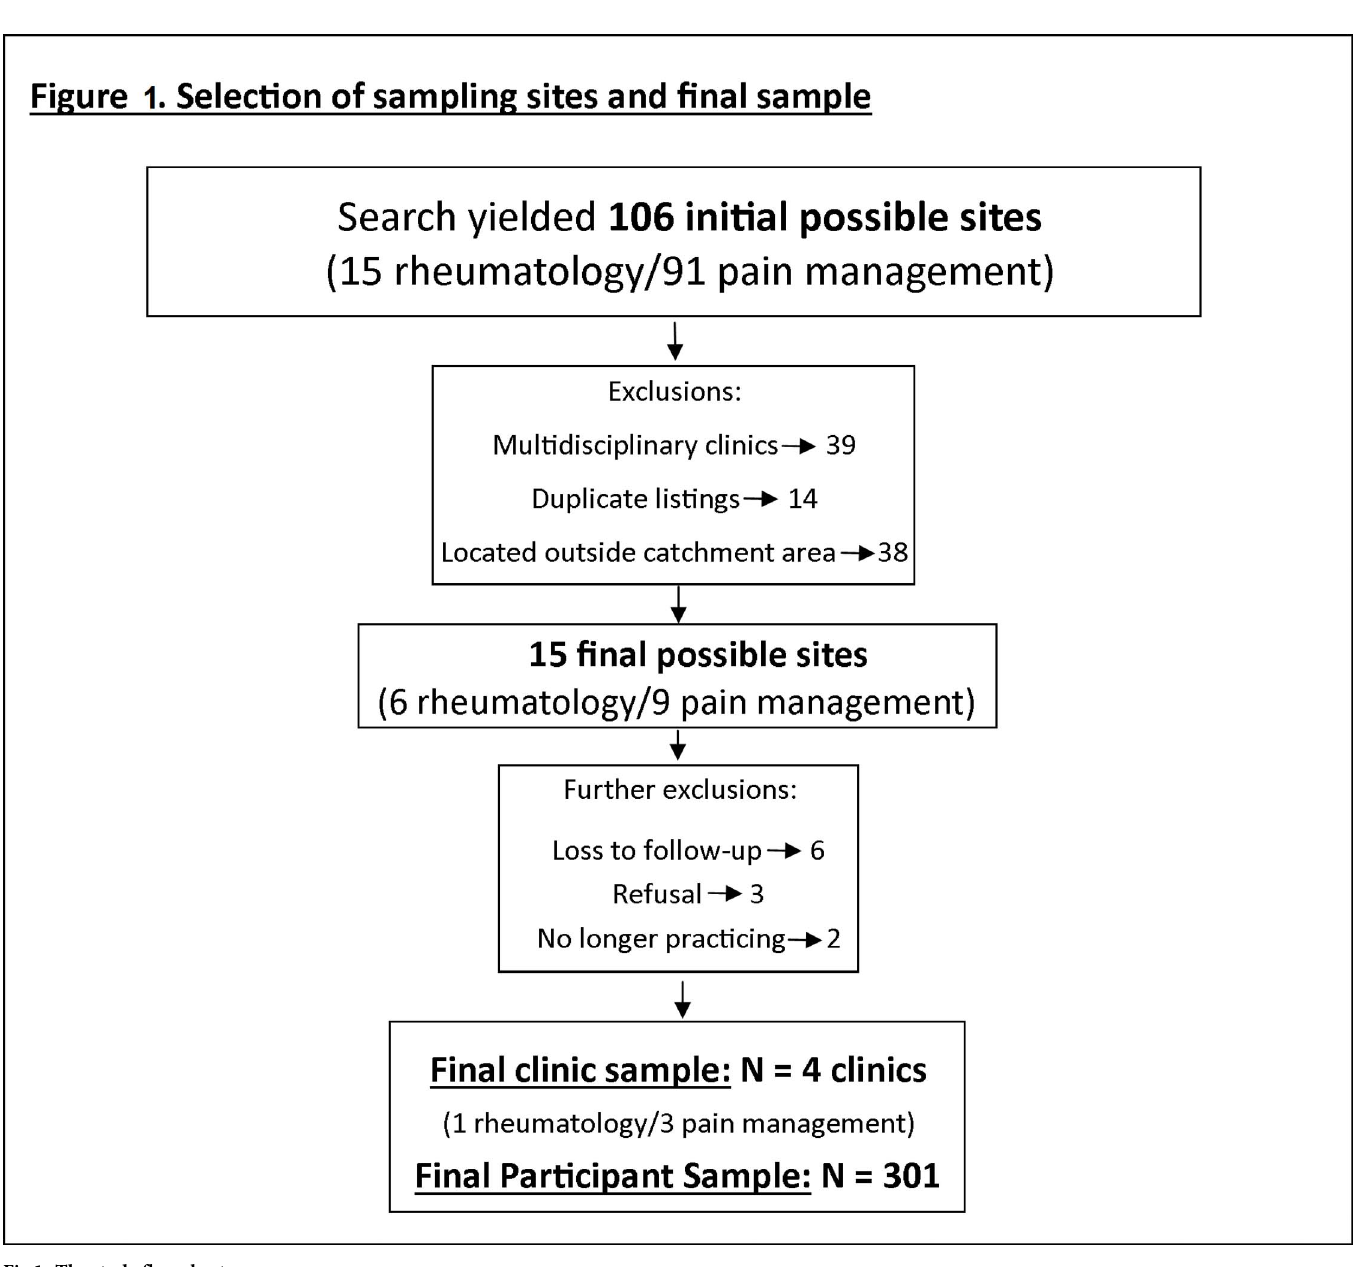
Fig 1. The study flow